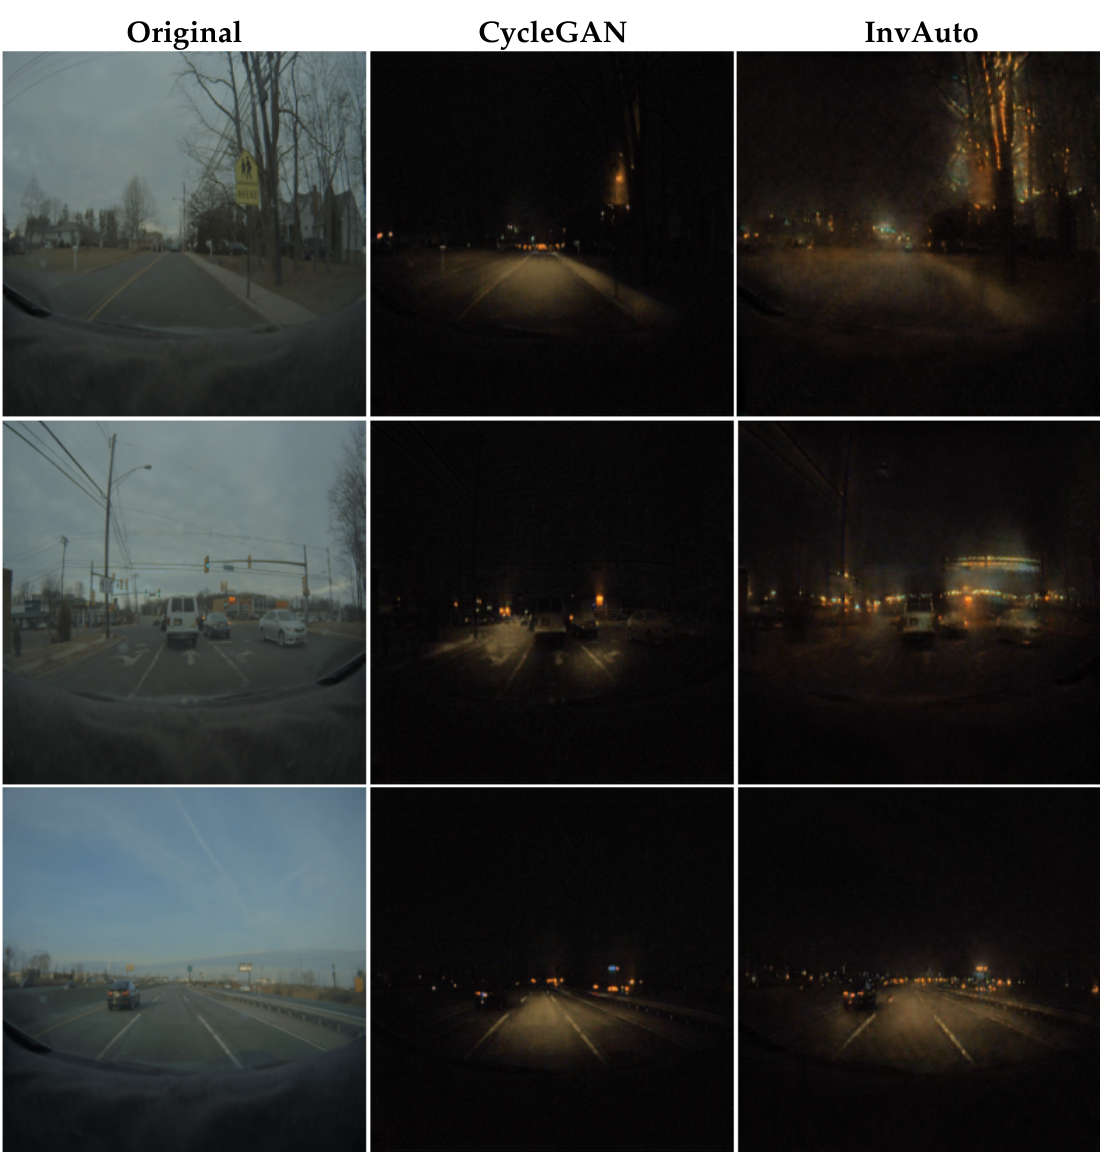
Figure A11. Experimental results with autonomous driving system: day-to-night